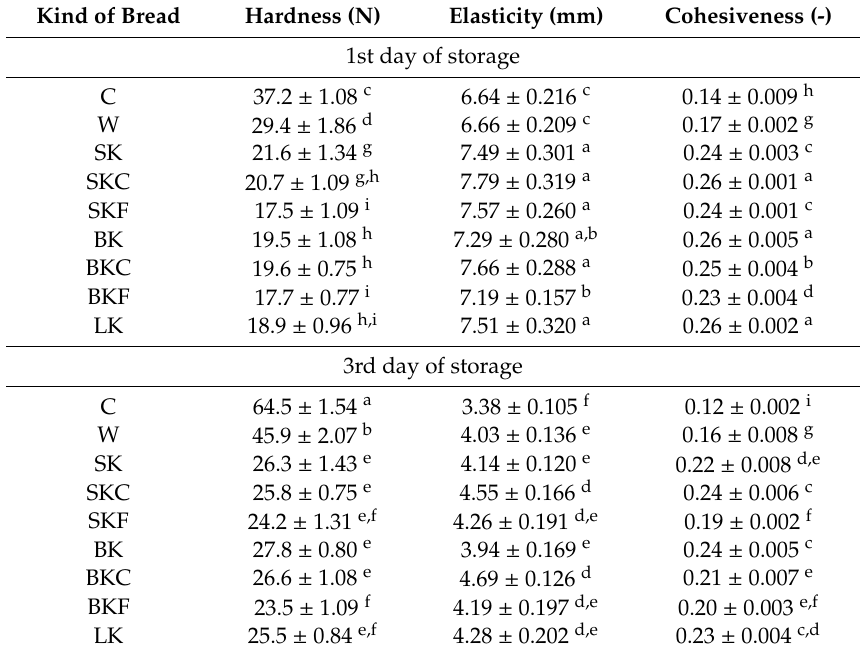
Table 2. Texture parameters of gluten-free bread with ground